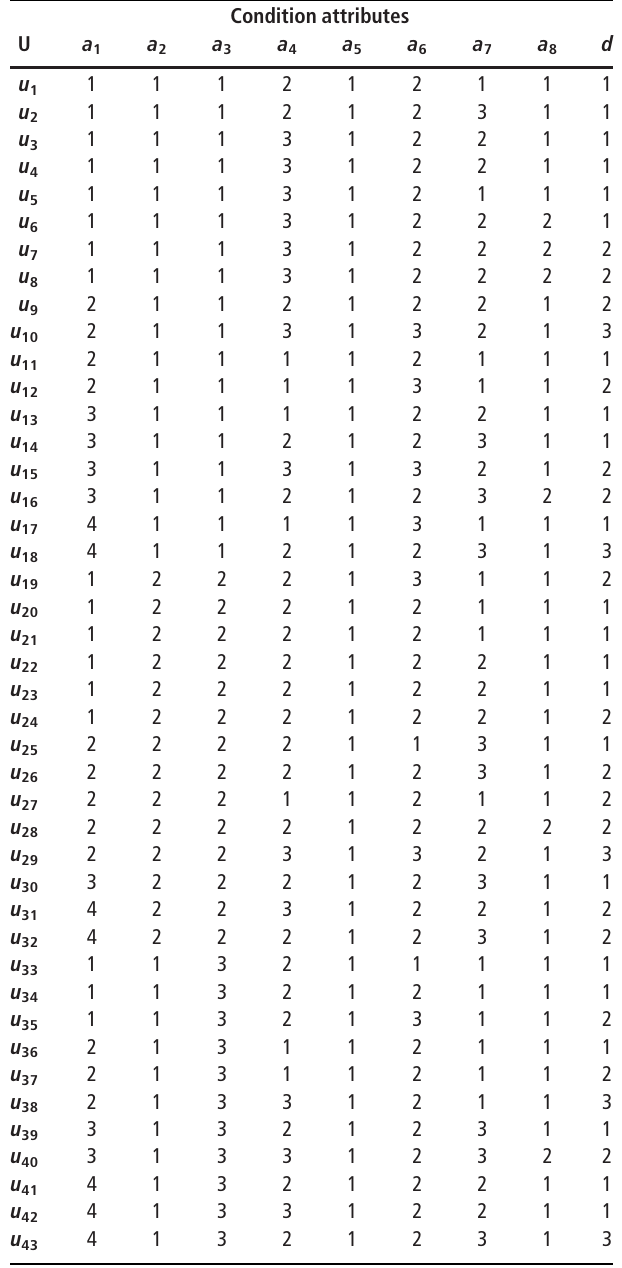
Table IV Decision table after quanti fi cation process with data from